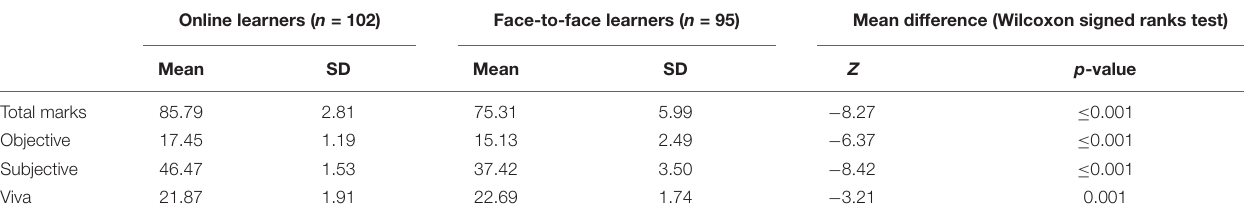
TABLE 8 | Paired-wise comparison between examination results of online and face-to-face